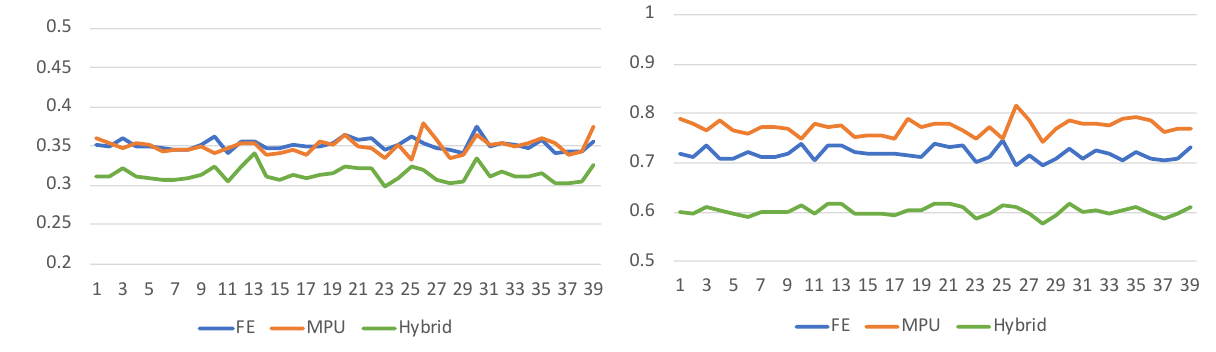
Figure 7. The standard deviation ( left ) (on average: Hybrid—0.31, FE—0.35, MPU—0.35) and arithmetic mean ( right ) (on average: Hybrid—0.60, FE—0.71, MPU—0.77) of the error values for each of the 39 cerebral cortices presented in the Table 3 and Appendix A, and reconstructed with FE, MPU, and Hybrid. The hybrid method has a lower standard deviation and arithmetic